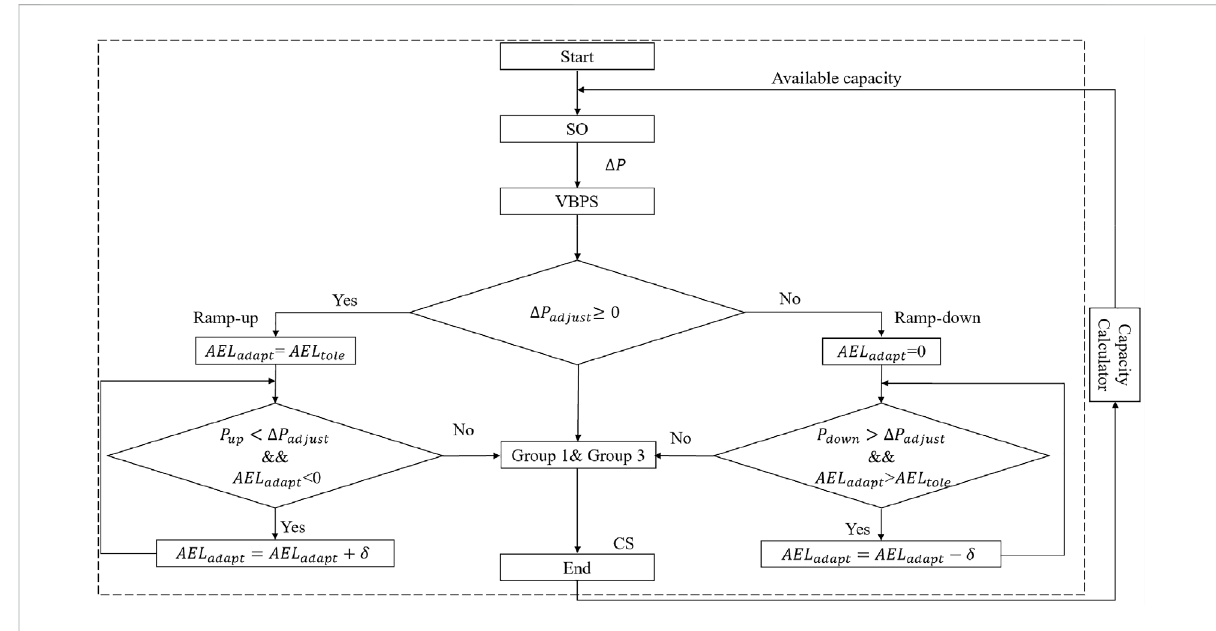
FIGURE 3 Schematic representation of the VBPS that provides ancillary services.